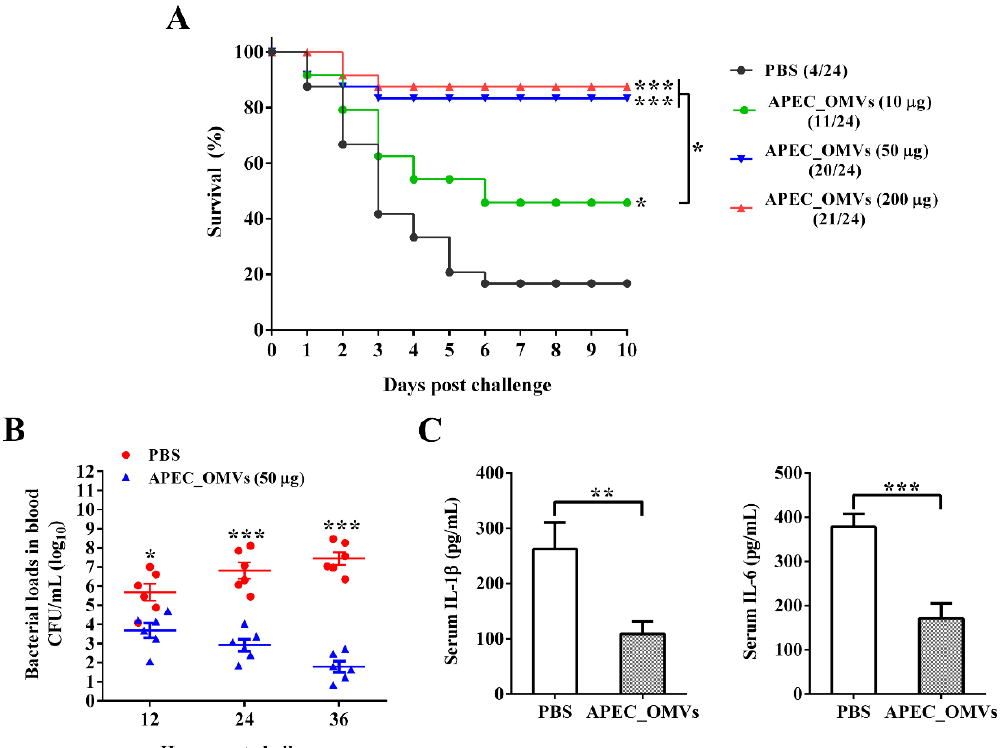
Figure 4. Protective efficacy conferred by APEC_OMV vaccination against homologous challenge in broiler chicks. ( A ) Survival rates of PBS- and APEC_OMV-immunized birds after bacterial challenge (n = 24). The number of surviving chicks in each group was recorded daily for 10 consecutive days after bacterial challenge. ( B ) Bacterial loads in peripheral blood collected from PBS- and APEC_OMV (50 µ g)-immunized chicks at indicated times after bacterial challenge (n = 6). ( C ) The production of proinflammatory cytokines (IL-1 β and IL-6) in the serum collected from PBS- and APEC_OMV (50 µ g)-immunized chicks at 22 days of age (24 h after bacterial challenge) (n = 6). Data are presented as mean ± SE. * p < 0.05; ** p < 0.01; *** p < 0.001, versus the respective control.